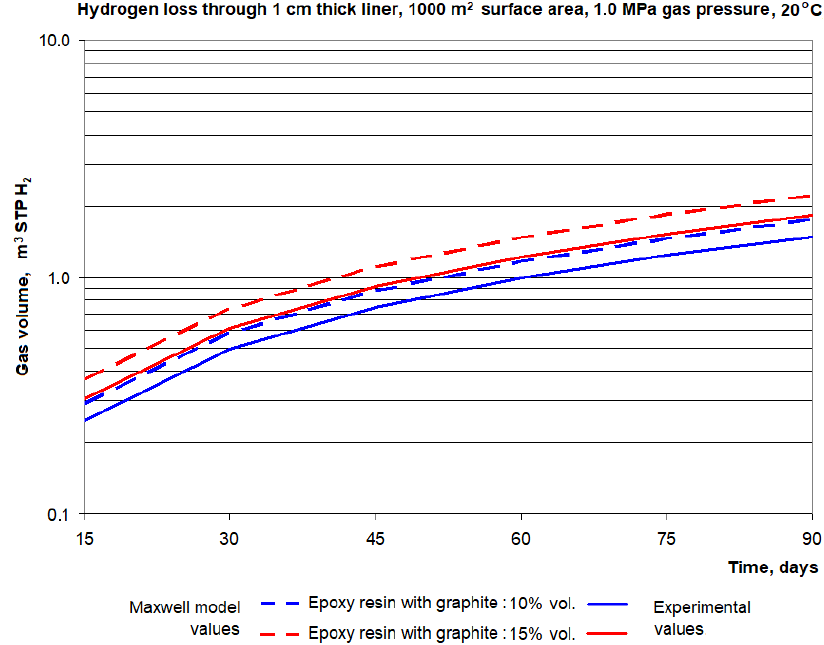
Figure 7. Comparison of hydrogen leakage, based on experimental and Maxwell model permeability results (1 cm thick, 1000 m 2 surface area, 20 °C).